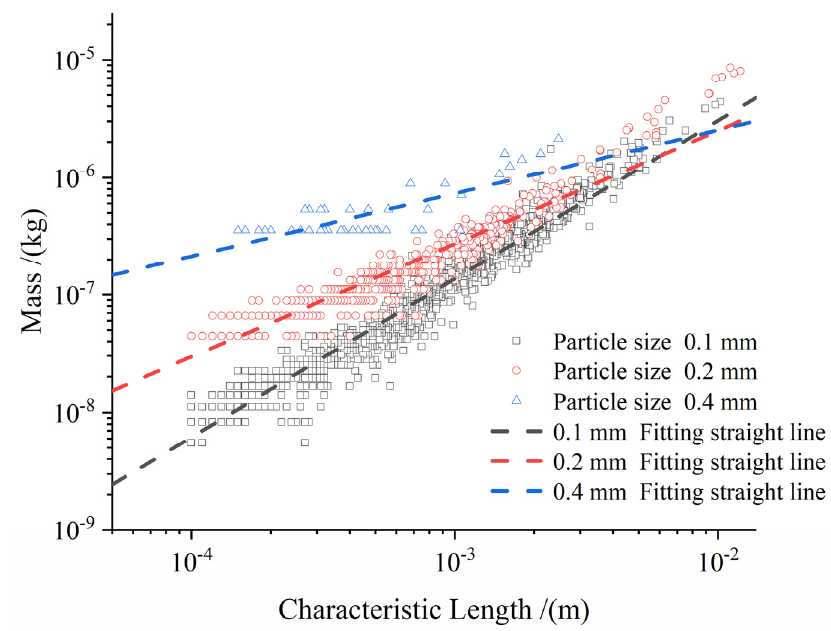
Figure 11. Characteristic length vs mass under different particle sizes.